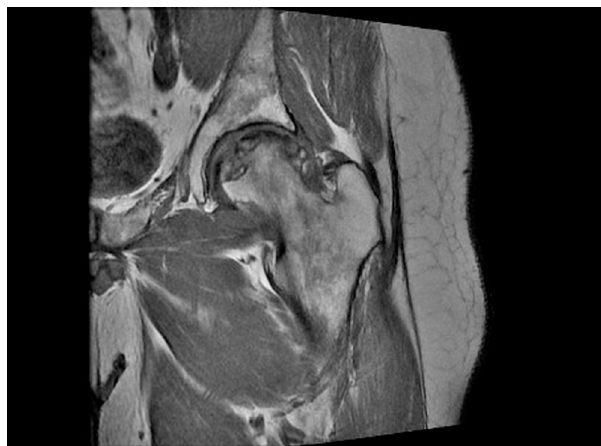
Figure 2. Pre-operative